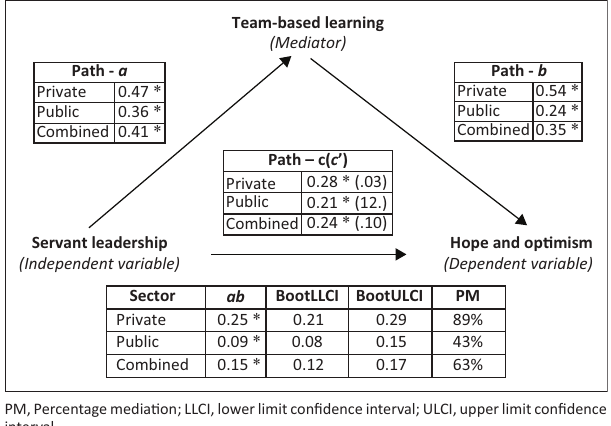
Team-based learning